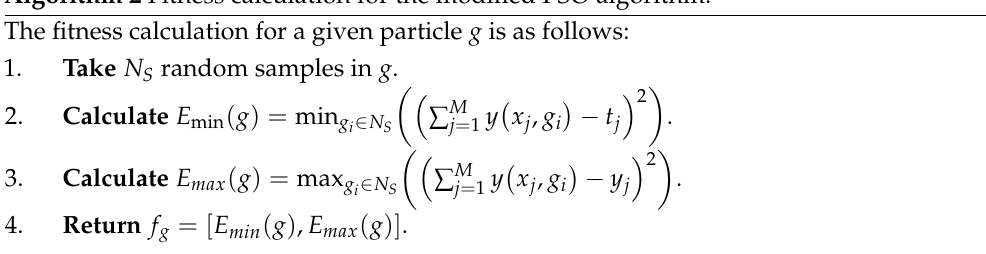
Algorithm 2 Fitness calculation for the modified PSO